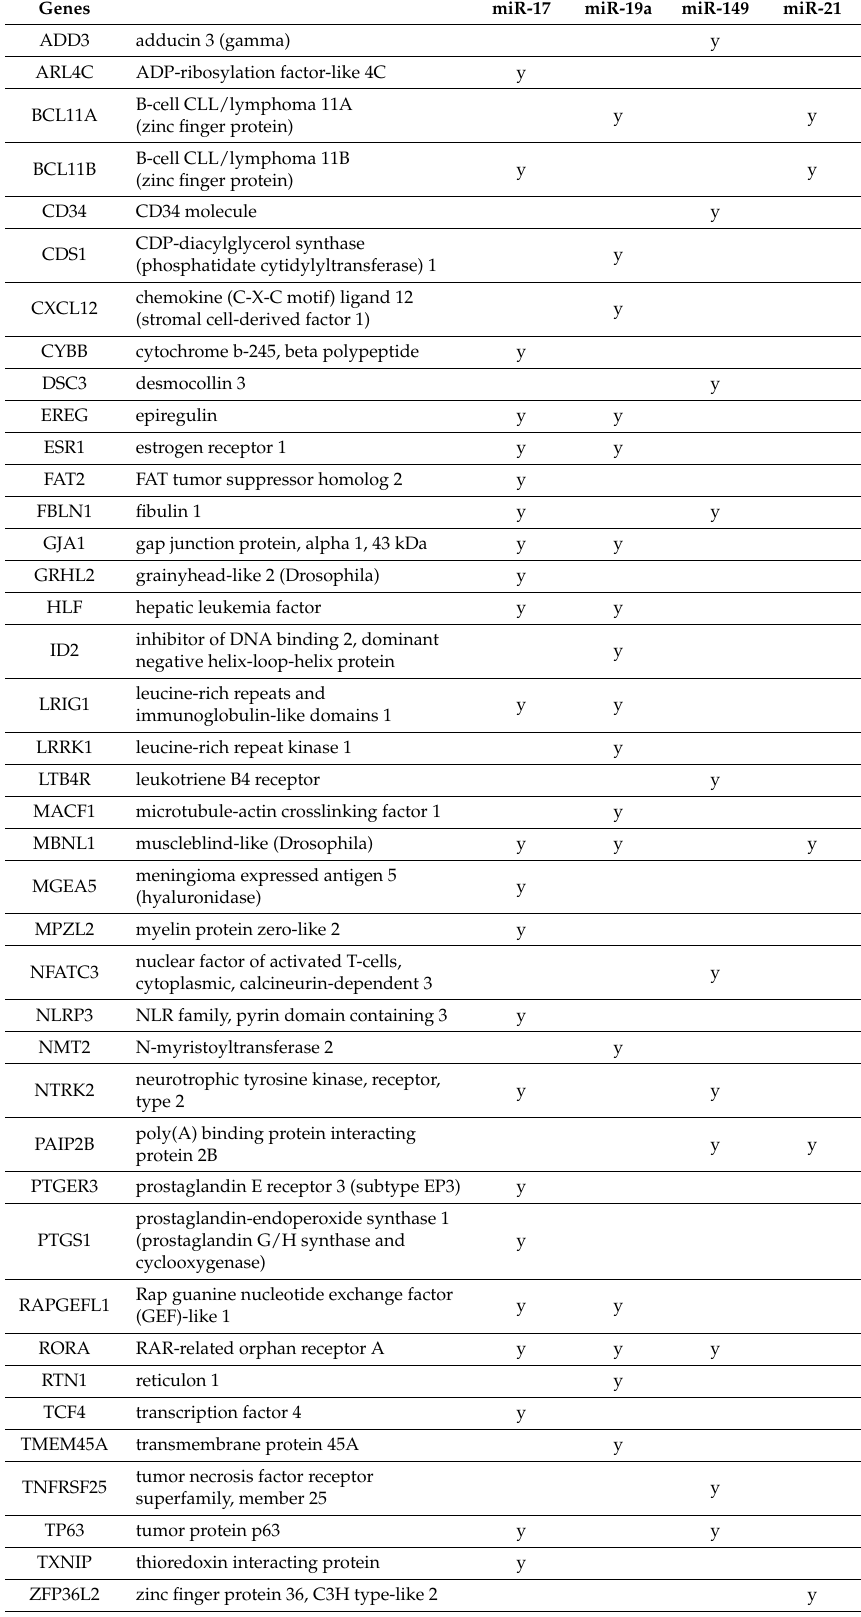
Table 6. Putative targets of miRNAs upregulated in metastatic melanoma. Genes miR-17 miR-19a miR-149 miR-21